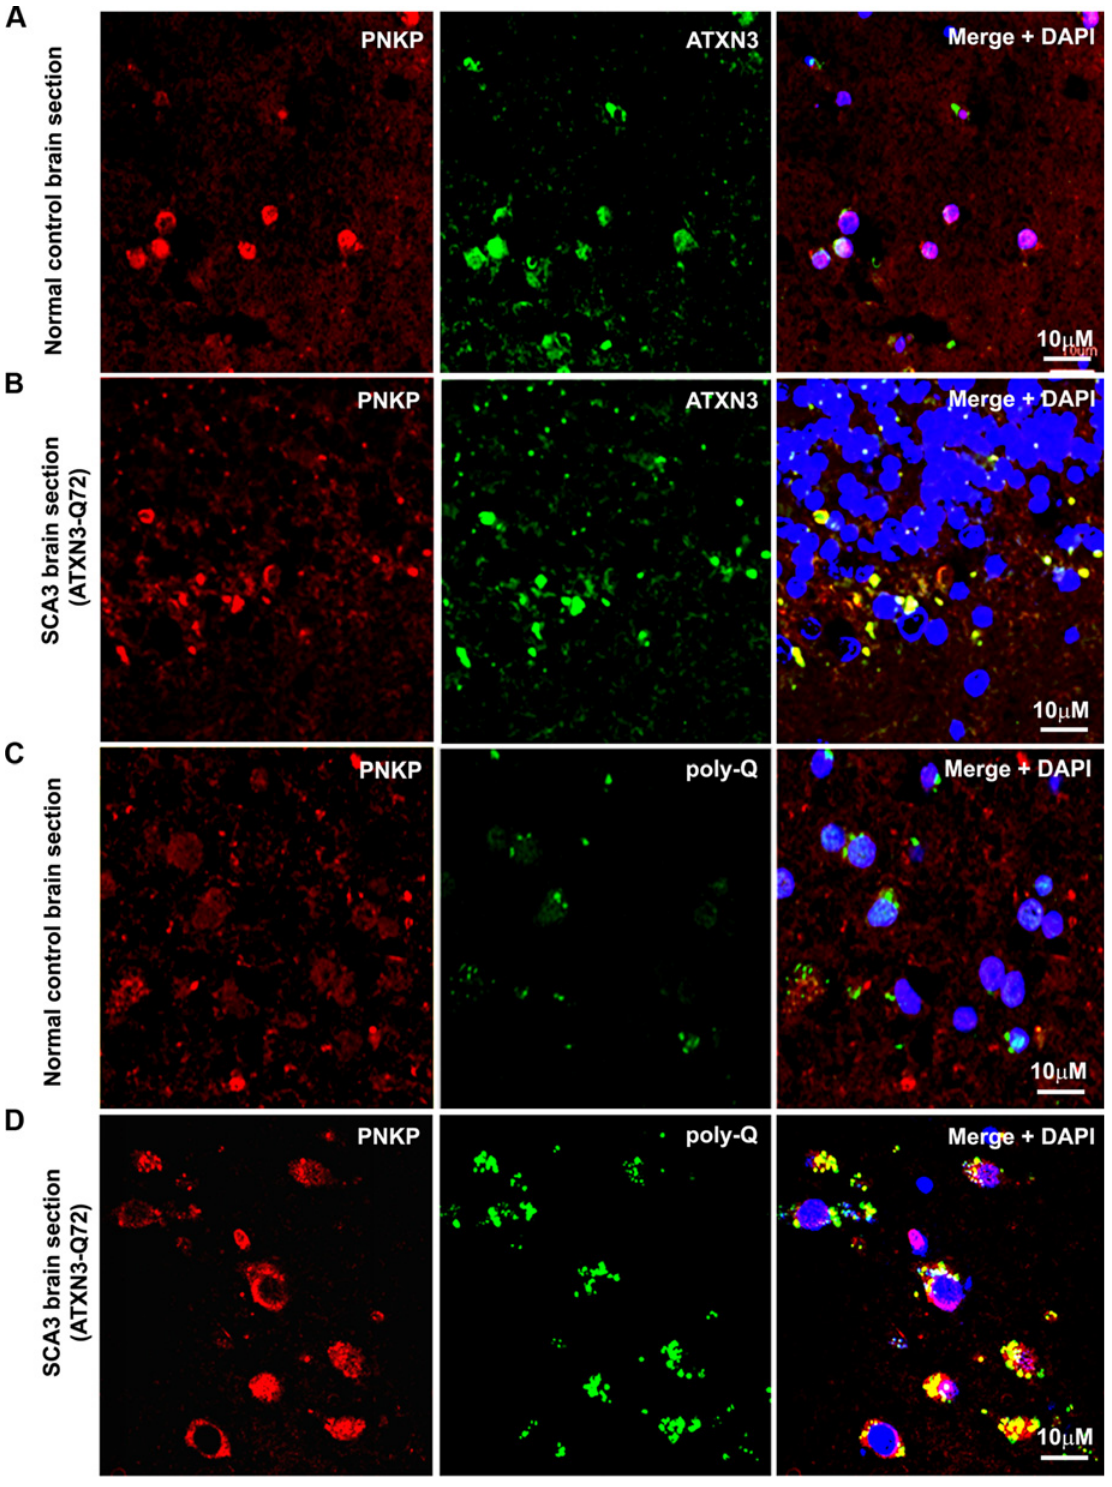
Figure 2. PNKP co-localizes with wild-type and mutant ATXN3 in human brain sections. (A) Normal human brain sections were analyzed by immunostaining with anti-PNKP (red) and anti-ATXN3 (green) antibodies to assess in vivo interaction of PNKP and ATXN3; merge of red and green fluorescence appears as yellow/orange fluorescence, Nuclei were stained with DAPI in Figs. 1A to 1D; (B) SCA3 (expressing mutant ATXN3-Q72) brain sections were analyzed by immunostaining with anti-PNKP (red), and anti-ATXN3 (green) antibodies to assess in vivo interaction of PNKP and